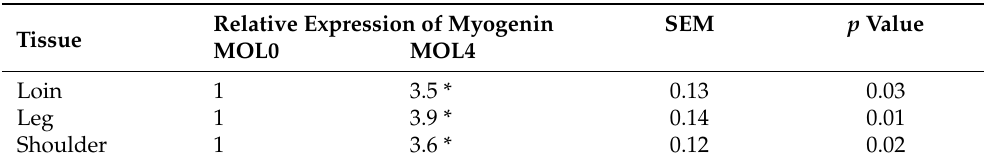
Table 3. The effect of diets on expression of myogenin gene in loin, leg, and shoulder muscle of Kermani lambs.